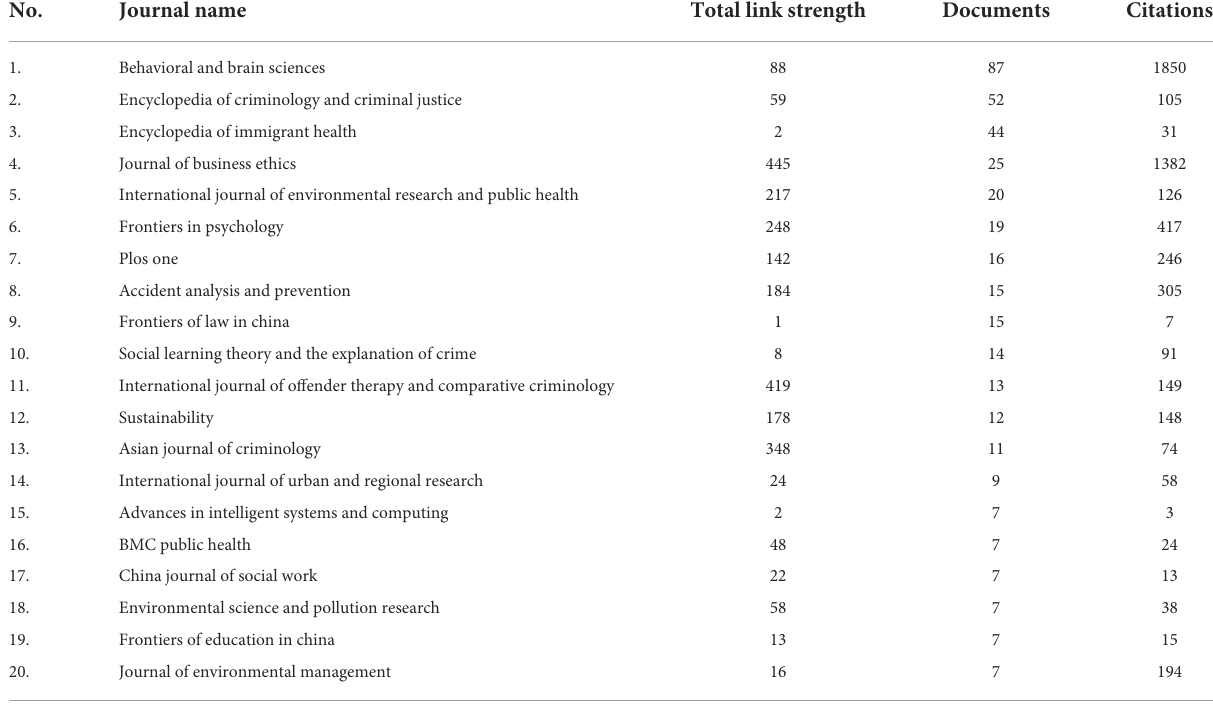
TABLE 1 No. of Publications based on Journals.